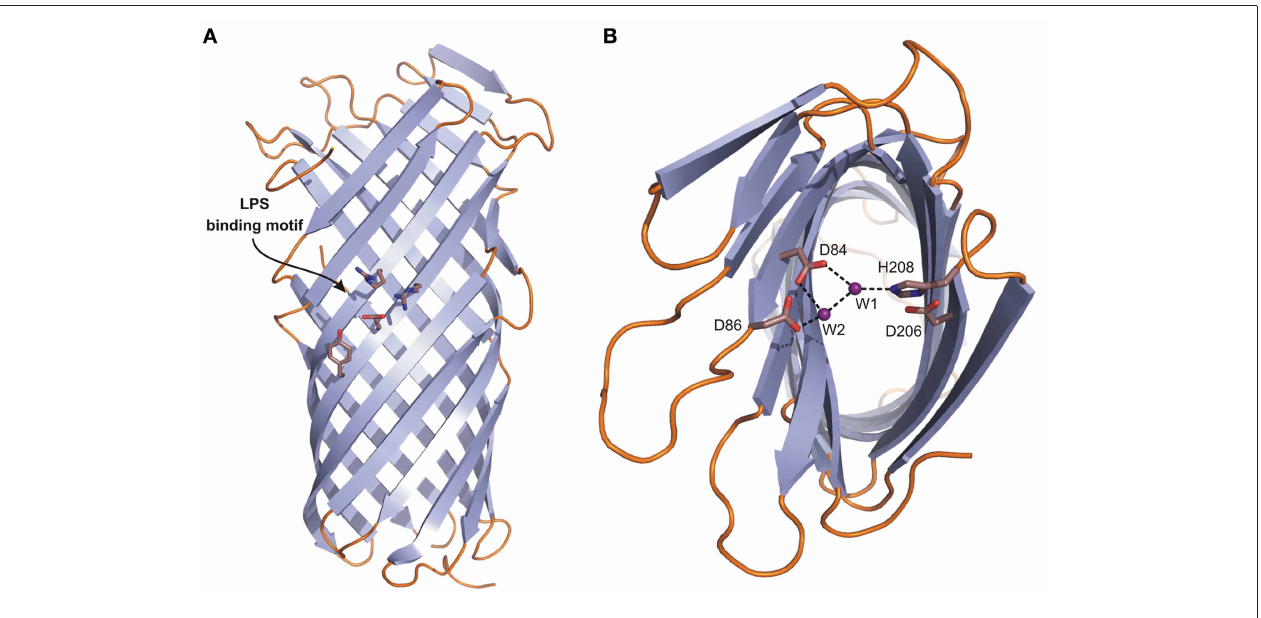
FIGURE 5 | The crystal structure of Pla from Y. pestis . Topology diagrams of the Pla structure (2X55). (A) Side view presenting the position of the putative LPS binding site (residues D84, D86, D206, and H208 in stick representation). (B) Top view showing